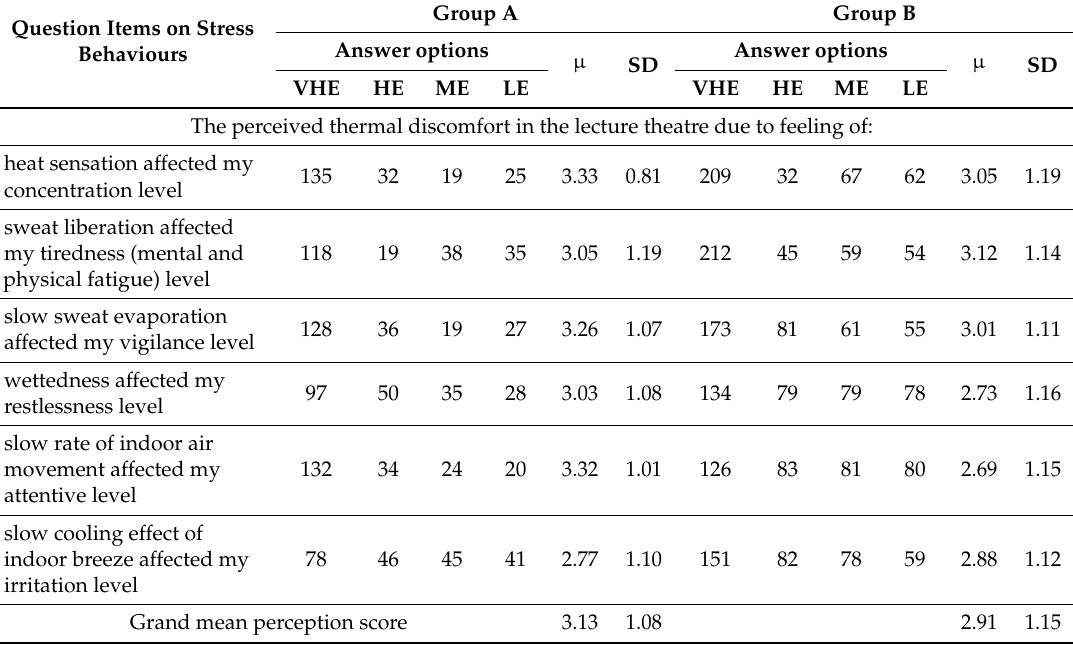
Table A2. Students’ Perceived Stress Behaviour Levels Affecting Learning in the Lecture